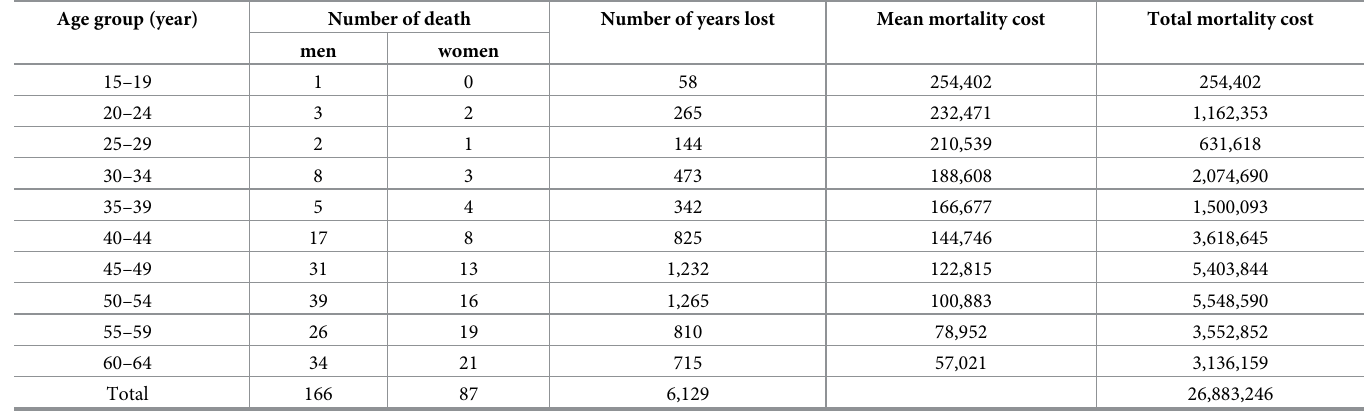
Table 5. The indirect costs of oral cancer due to premature mortality in Iran in 2014.